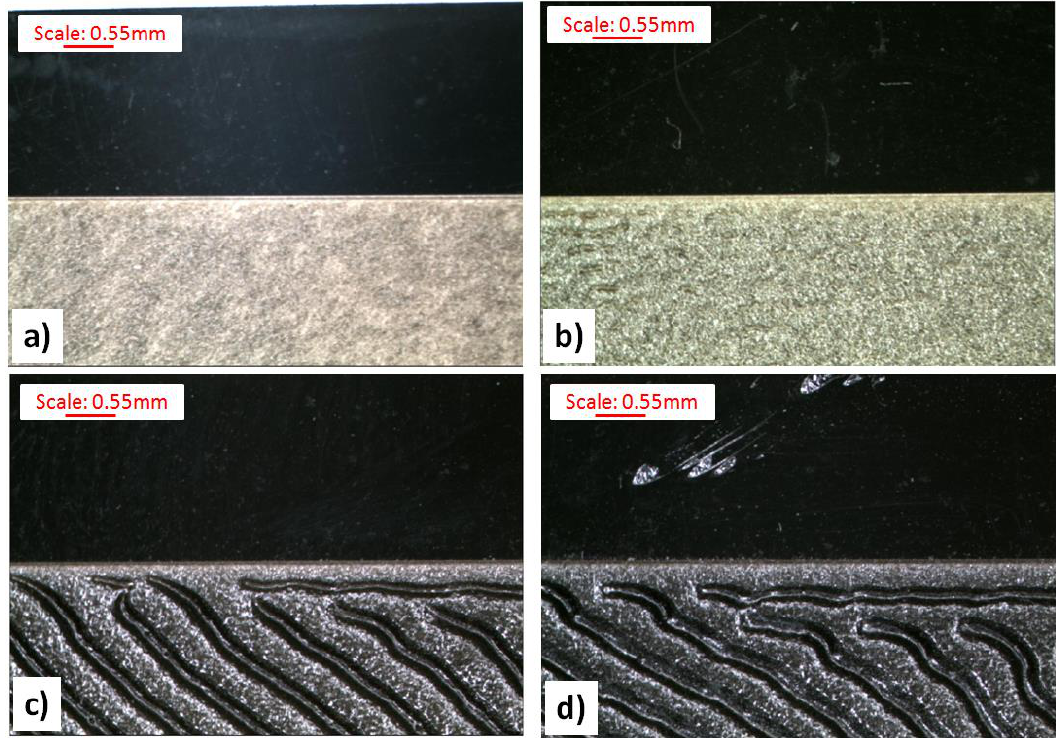
Figure 8. Influence of the Lifolas M Schwarz 113504 UN additive content on the surface condition of the P surface before and after the marking at velocity A (450 mm · s − 1 ): ( a ) 0.0 wt% content, ( b ) 0.5 wt% content, ( c ) 1.5 wt% content, and ( d ) 2.5 wt% content.